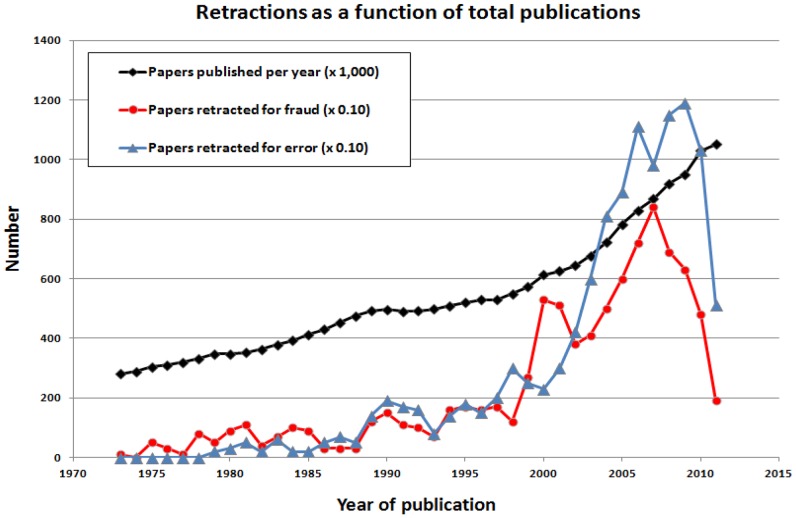
Papers published and retracted per year since 1973.Note that the multipliers are different. For the sake of simplicity, error here includes all infractions except fraud (e.g., scientific error, plagiarism, duplication, other). Apparent declines in recent years must be interpreted with caution as additional papers may be retracted in the future, thereby reversing this decline.